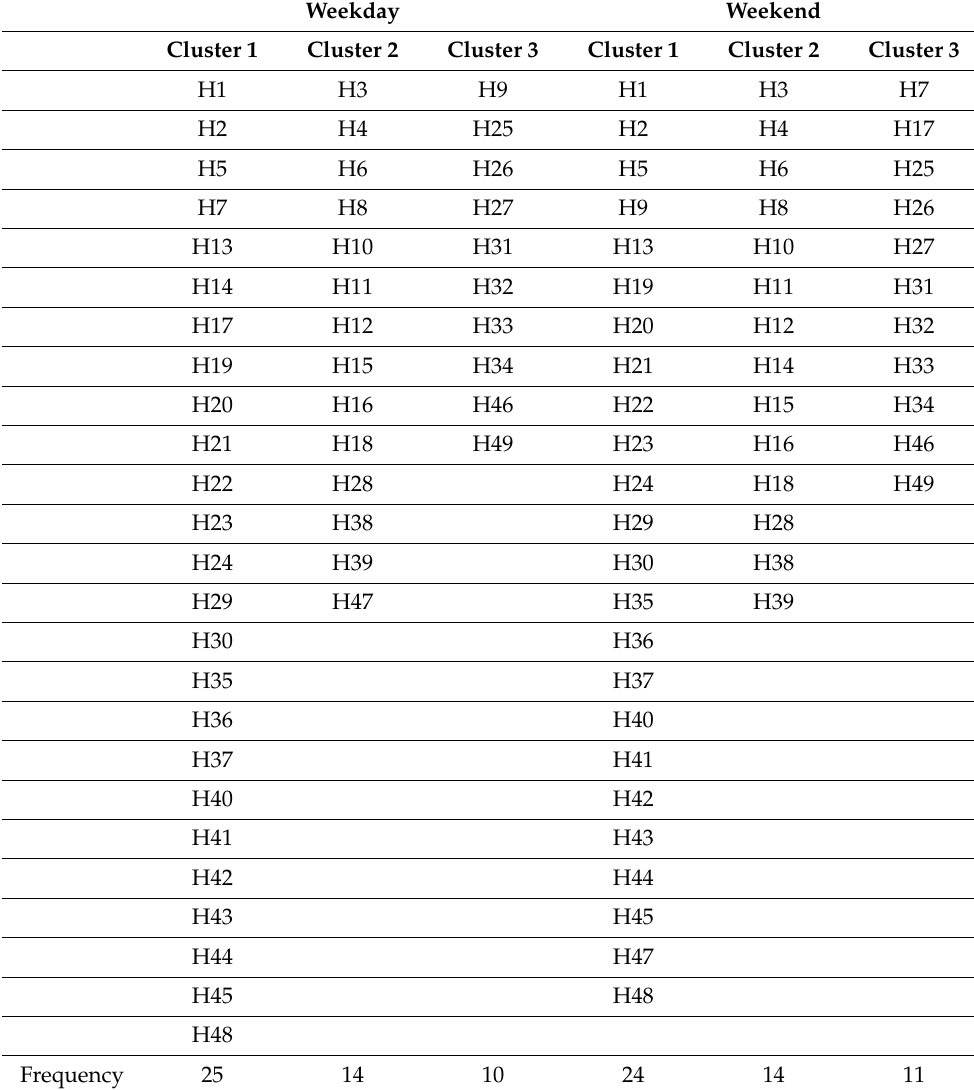
Table 2. Clusters’ membership of the cases for weekdays and weekends in